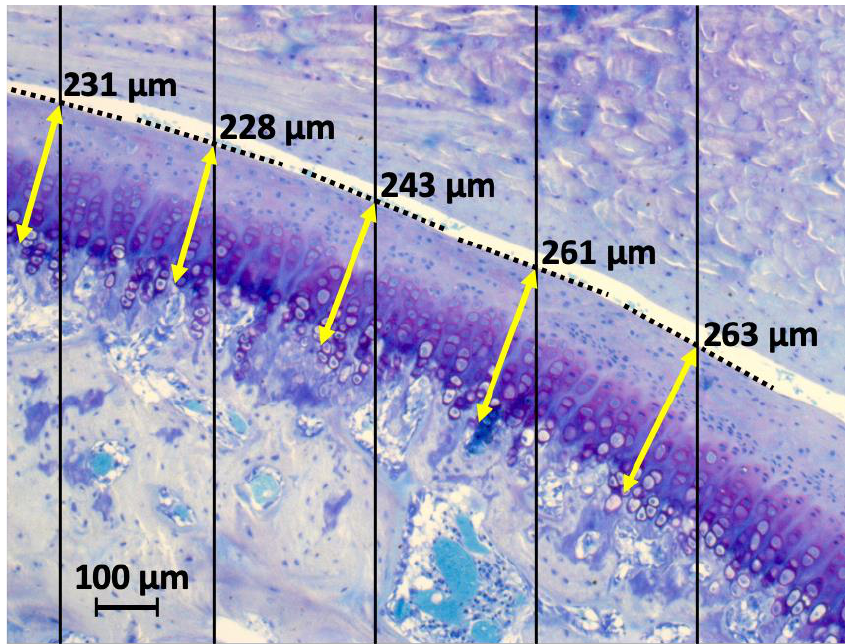
Figure 1. To objectify the cartilage thickness measurements, a line grid (black) was used to define random measuring points on the cartilage surface. At these points the thickness measurement (yellow) was finally taken, each right angled to an imaginary tangent (dotted).